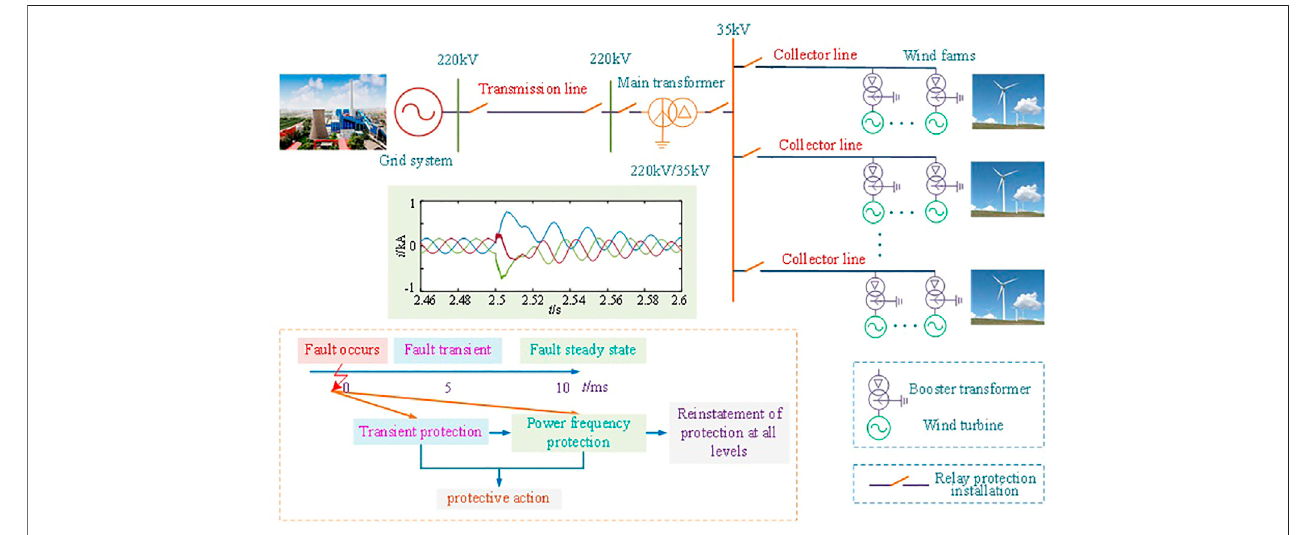
FIGURE 1 | Large-scale wind farms system, short-circuit current waveform, and protection coordination scheme of the transmission line.